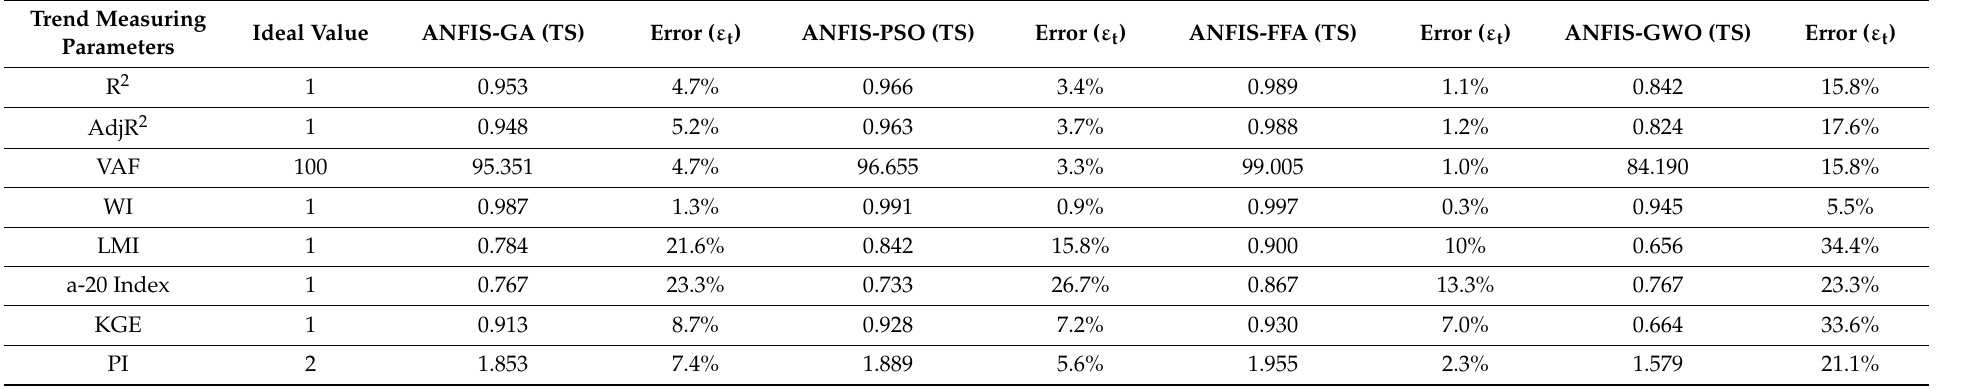
Table 9. Computed error for trend measuring parameters (testing